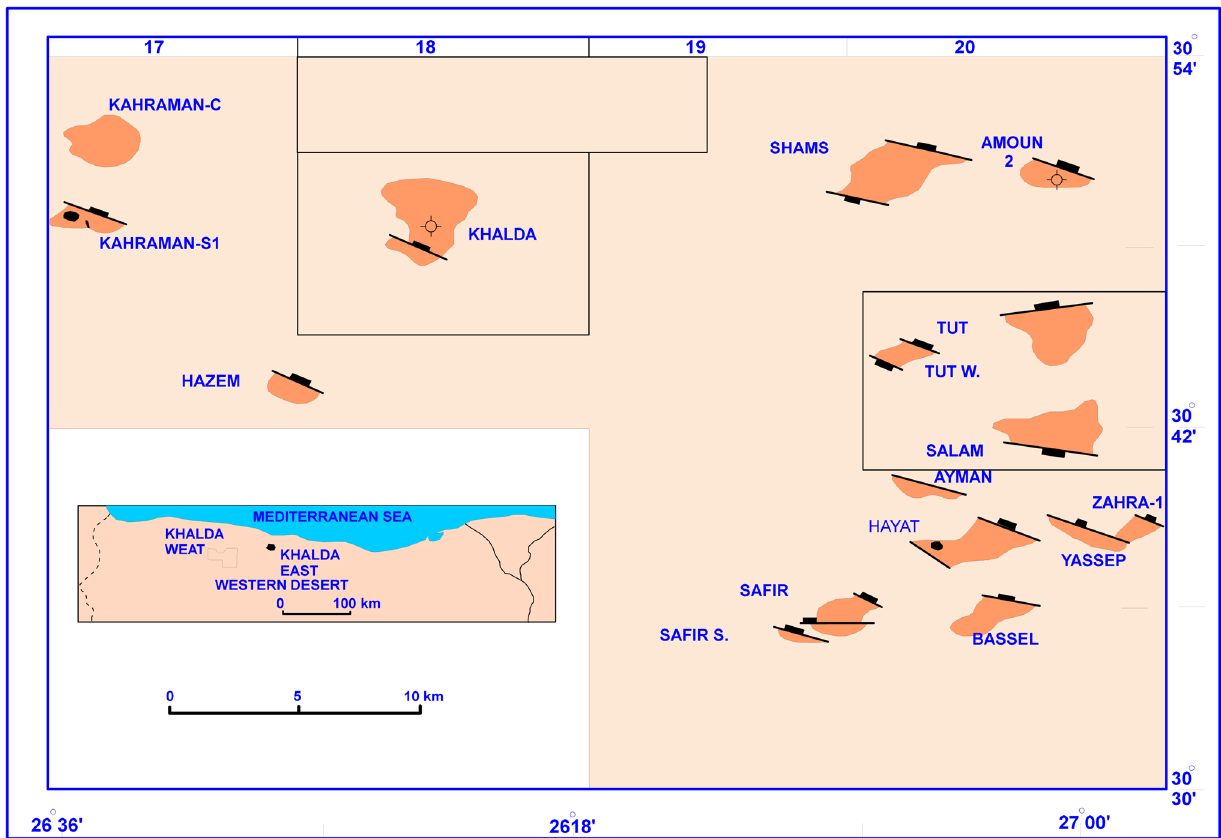
Fig. 4 Location map of the Khalda Field within the Khalda West Concession (Abed El Aziz